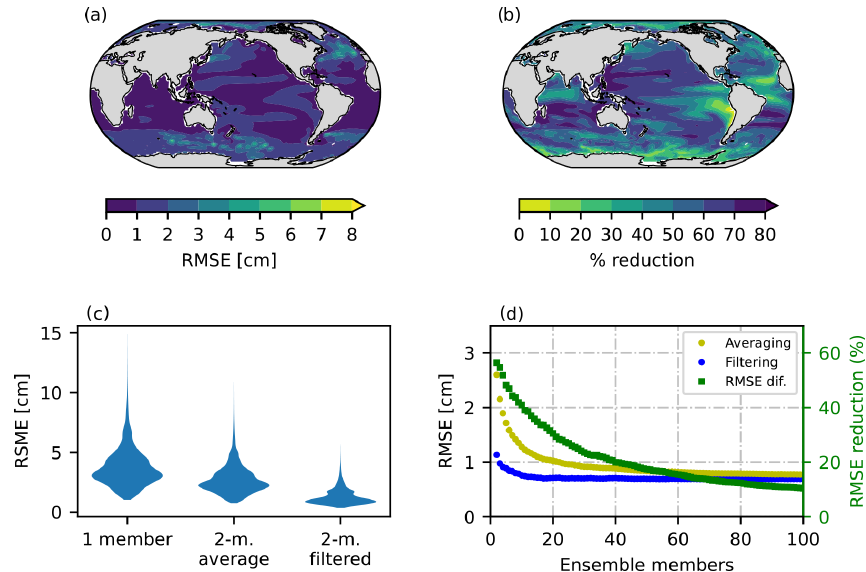
Figure 6. Regional pattern scaling performance based on regression RMSE when two ensemble members are used to estimate the forced response via S/N M EOF pattern filtering (a) . Panel (b) shows the difference in regression performance between the two-member average pattern scaling (Fig. 5b) and the S/N M EOF-filtered equivalent (a) . Panel (c) shows violin plots of RMSE distributions from the one-member, two-member average, and two-member S/N M EOF-filtered approaches. Panel (d) shows the area-weighted average RMSE obtained in the regression as a function of the number of ensemble members included when using an ensemble mean (yellow) and filtering (blue). The difference in performances in terms of percentage is shown in green. The analysis is for the RCP2.6 scenario (we observed no discernible differences between